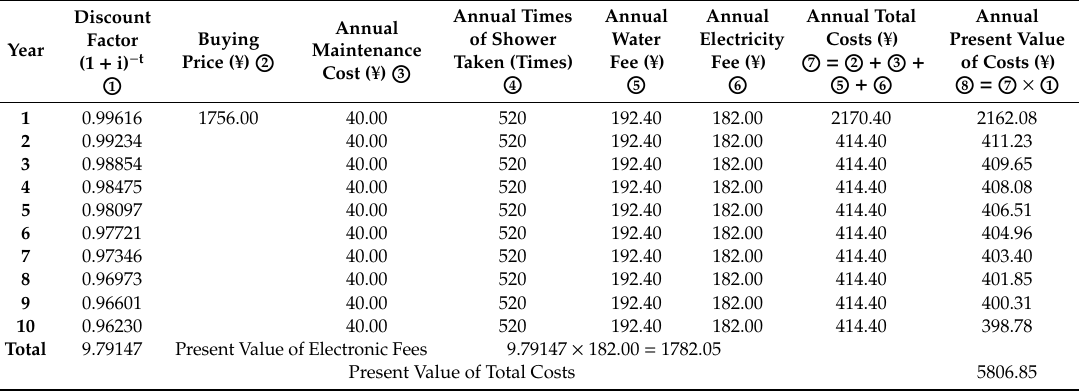
Table 9. Present value of the total costs of using an electronic water